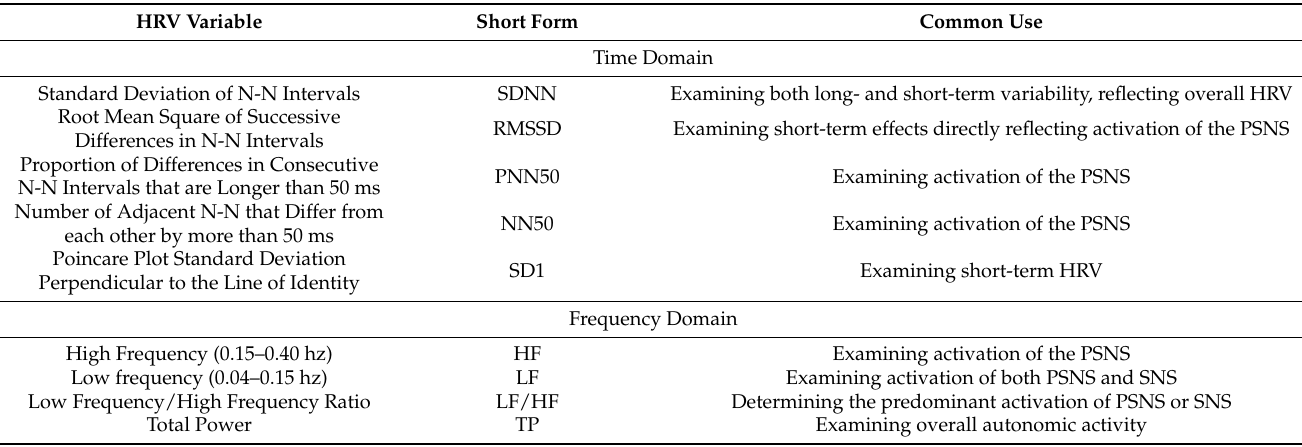
Table 1. Main HRV Analysis